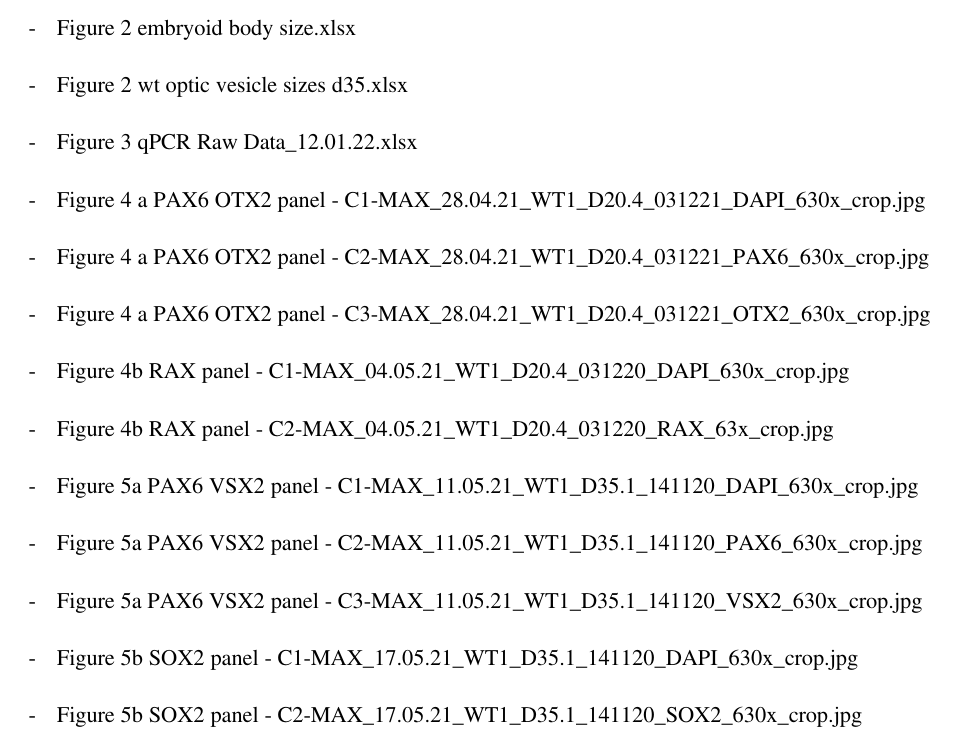
‐ Figure 2 Embryoid bodies n1.jpg ‐ Figure 2 Embryoid bodies n2.jpg ‐ Figure 2 Embryoid bodies n3.jpg ‐ Figure 2 Embryoid bodies zoom.jpg ‐ Figure 2 embryoid body size.xlsx ‐ Figure 2 wt optic vesicle sizes d35.xlsx ‐ Figure 3 qPCR Raw Data_12.01.22.xlsx ‐ Figure 4 a PAX6 OTX2 panel - C1-MAX_28.04.21_WT1_D20.4_031221_DAPI_630x_crop.jpg ‐ Figure 4 a PAX6 OTX2 panel - C2-MAX_28.04.21_WT1_D20.4_031221_PAX6_630x_crop.jpg ‐ Figure 4 a PAX6 OTX2 panel - C3-MAX_28.04.21_WT1_D20.4_031221_OTX2_630x_crop.jpg ‐ Figure 4b RAX panel - C1-MAX_04.05.21_WT1_D20.4_031220_DAPI_630x_crop.jpg ‐ Figure 4b RAX panel - C2-MAX_04.05.21_WT1_D20.4_031220_RAX_63x_crop.jpg ‐ Figure 5a PAX6 VSX2 panel - C1-MAX_11.05.21_WT1_D35.1_141120_DAPI_630x_crop.jpg ‐ Figure 5a PAX6 VSX2 panel - C2-MAX_11.05.21_WT1_D35.1_141120_PAX6_630x_crop.jpg ‐ Figure 5a PAX6 VSX2 panel - C3-MAX_11.05.21_WT1_D35.1_141120_VSX2_630x_crop.jpg ‐ Figure 5b SOX2 panel - C1-MAX_17.05.21_WT1_D35.1_141120_DAPI_630x_crop.jpg ‐ Figure 5b SOX2 panel -